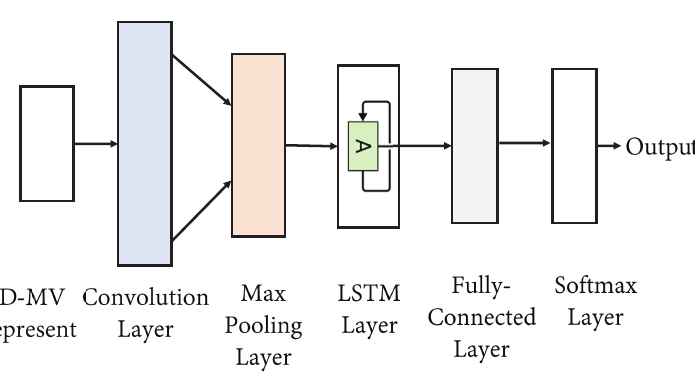
Figure 4. An overview of the intelligent authentication